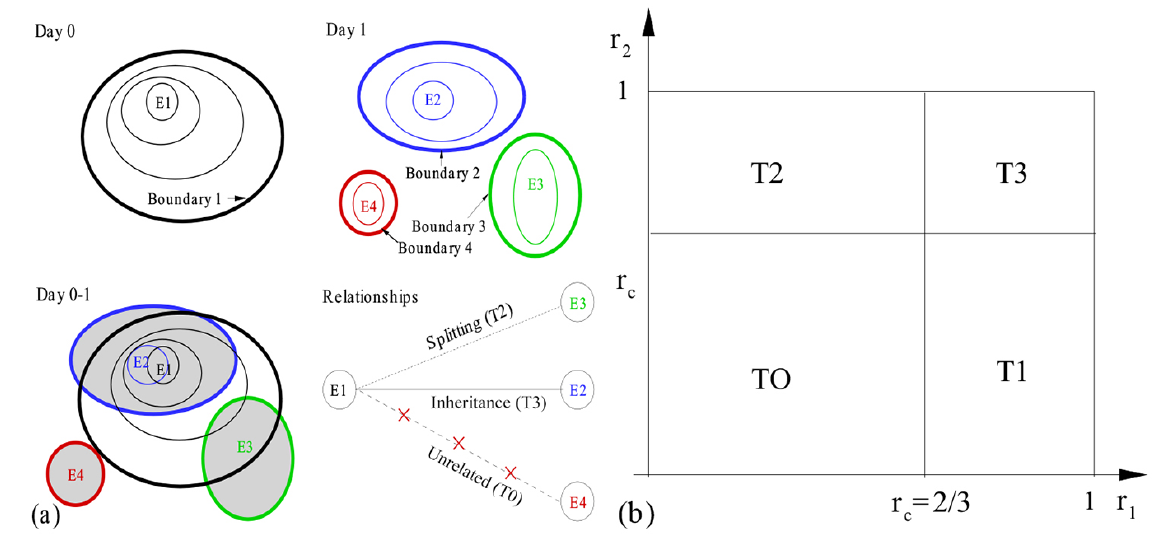
Figure 6. Sketch of eddy similarities. (a) The sketch of eddy overlaps. Eddy E1 (black) is the eddy identified on day 0, where the thin contours represent the eddy parameter (e.g., the SLA value). The thick contour represents the eddy boundary. Eddies E2 (blue), E3 (green), and E4 (red) are identified on day 1. We consider the overlap between the two eddies on different days to evaluate the similarity between them. (b) There are four similarity types (T0–T3) according to the values of r 1 , r 2 , and the critical value r c ; there is at most one eddy that can be marked as a T1 (merging) or T3 (living) eddy on the following